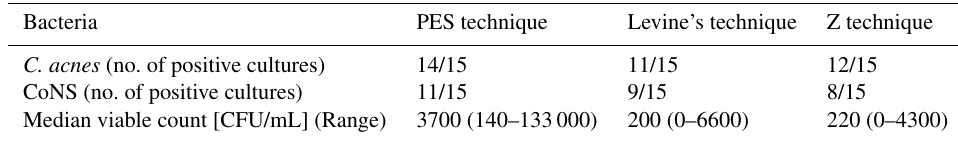
Table 1. Qualitative results; subjects with positive bacterial cultures ( n = 15). Bacteria